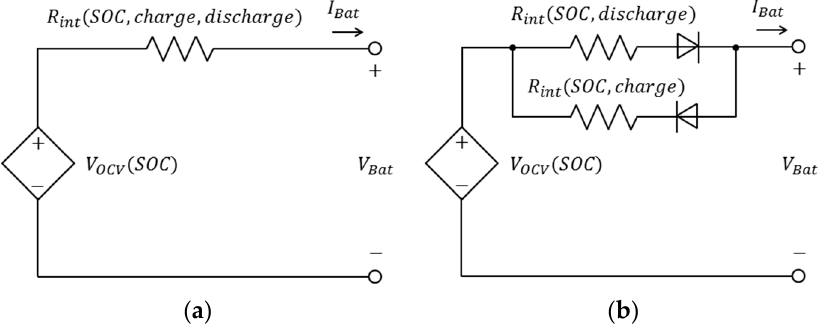
Figure 2. ( a ) Rint model. ( b ) Rint model with individual internal resistors .